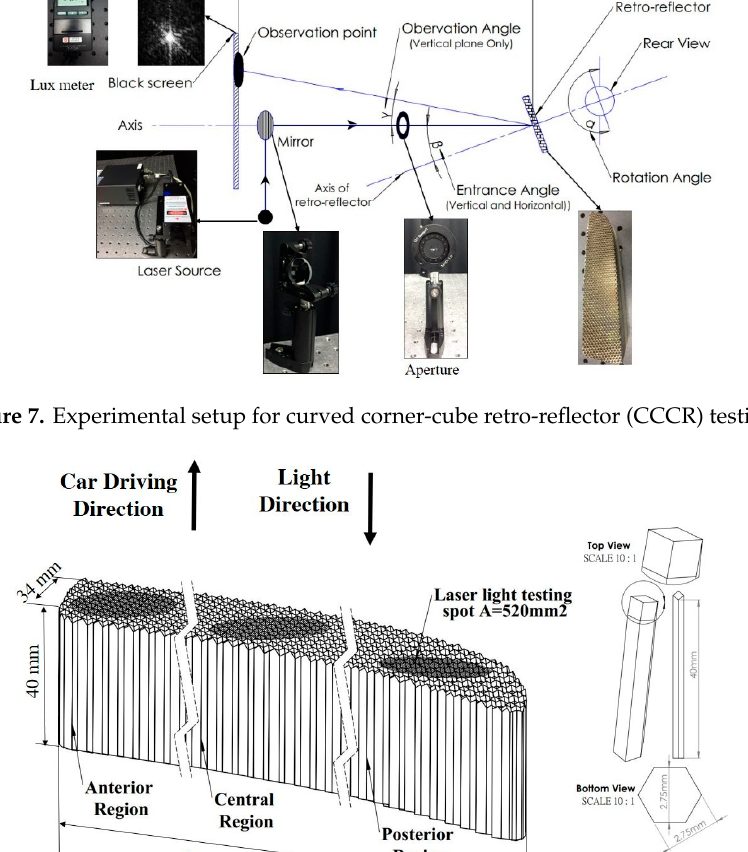
Figure 9. The retro-reflected outputs by ( a ) anterior, ( b ) central, and ( c ) posterior regions of the commercial SuperPin CCCR.